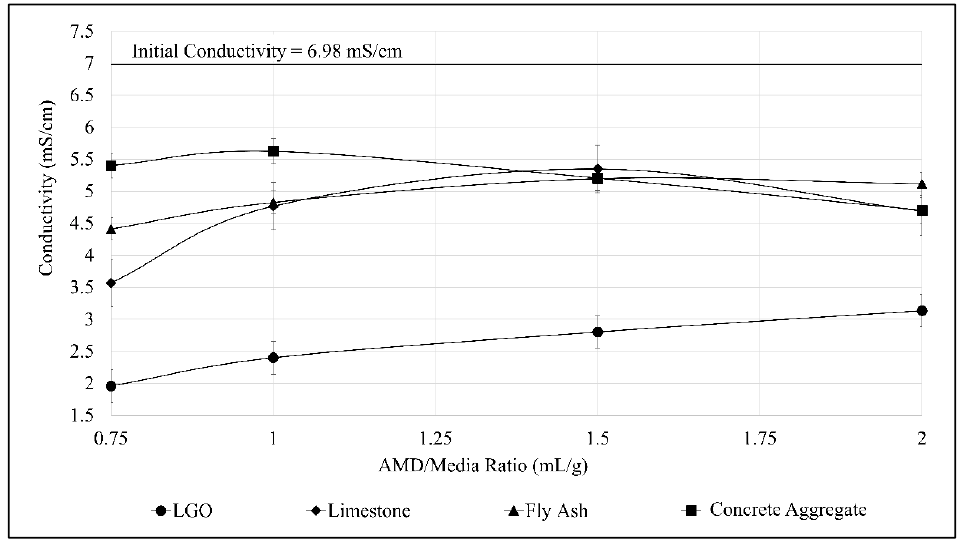
Figure 6. Effect of AMD/Media ratio on conductivity after 1-h mixing.